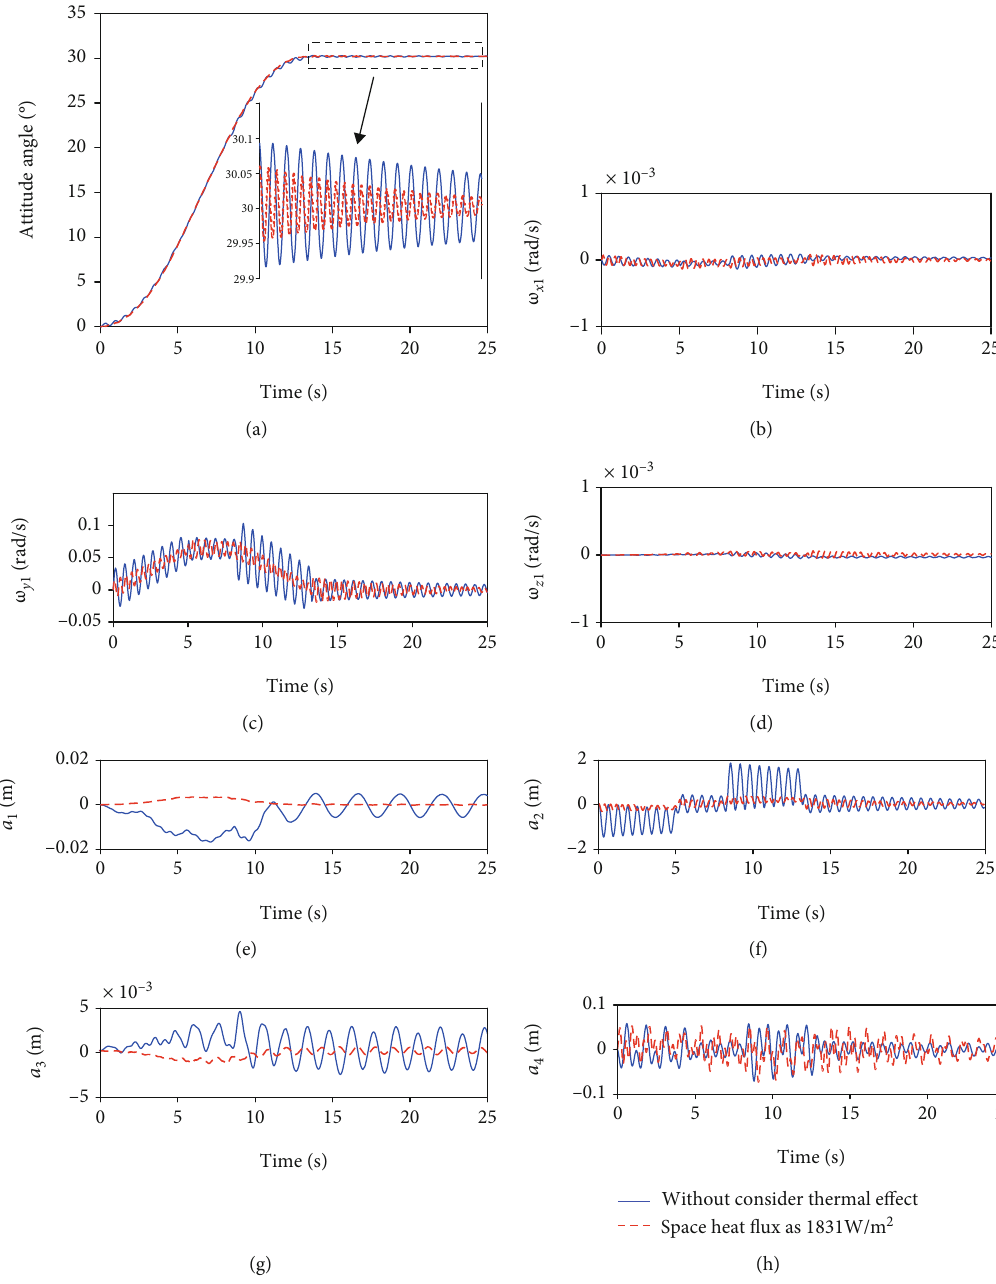
Figure 13: Dynamic response of the satellite-membrane-antenna system during the attitude maneuver with and without thermal e ff ects considered: (a) attitude angle; (b) angular velocity in the x 1 direction; (c) angular velocity in the y 1 direction; (d) angular velocity in the z direction; (e) fi rst-order modal coordinate; (f) second-order modal coordinate; (g) third-order modal coordinate; (h) fourth-order 1 modal